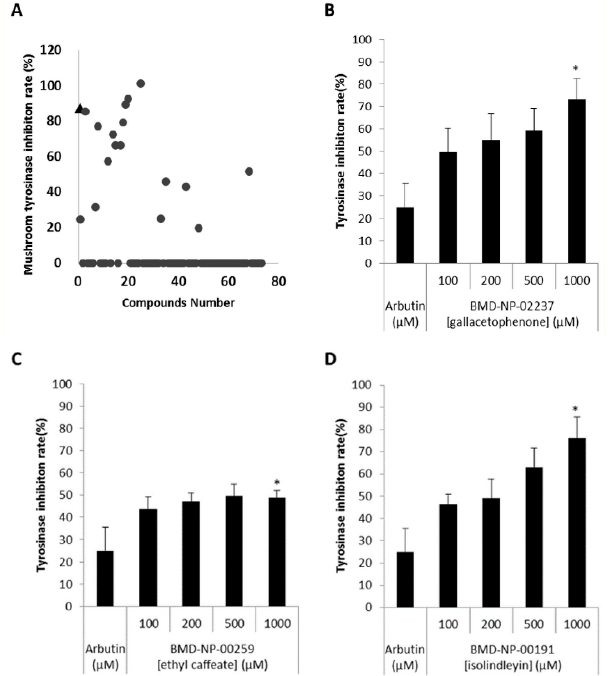
Figure 2. Mushroom tyrosinase inhibition rate using screened hit compounds. ( A ) A total of 74 compounds from docking-based high throughput virtual screening are represented in the graph in terms of mushroom tyrosinase inhibition rate. Arbutin, a positive control, is represented as a triangle ( ▲ ), while the other compounds are represented as circles ( ● ). Of the screened compounds, three were selected for another round of mushroom tyrosinase inhibition assay in a dose-dependent manner. The mushroom tyrosinase inhibition rate increased under treatment with ( B ) BMD-NP-02237(Gallacetophenone ) ; ( C ) BMD-NP-00259(Ethyl caffeate); and ( D ) BMD-NP-00191(Isolindleyin). Arbutin was treated at a concentration of 500 μ M. The assay results are normalized as per the manufacturer’s instruction. Data are expressed as the mean ± SD of at least three independent measurements (* p < 0.05).